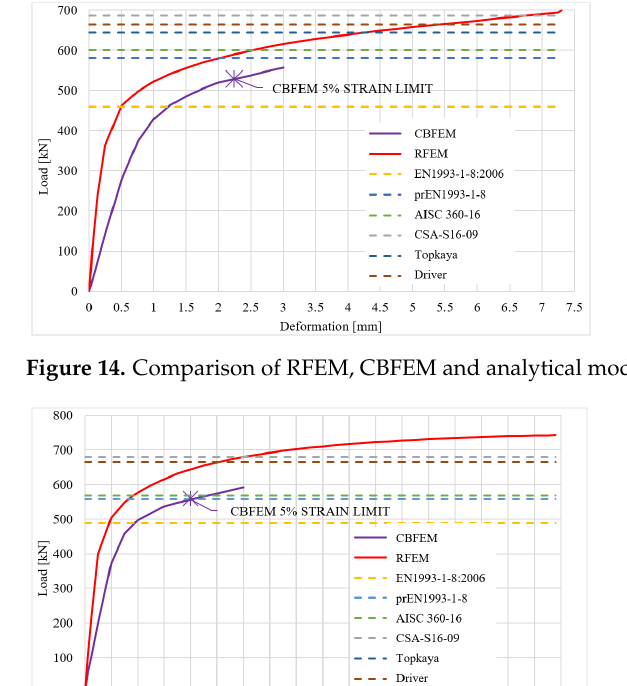
Figure 14. Comparison of RFEM, CBFEM and analytical models for specimen T1.